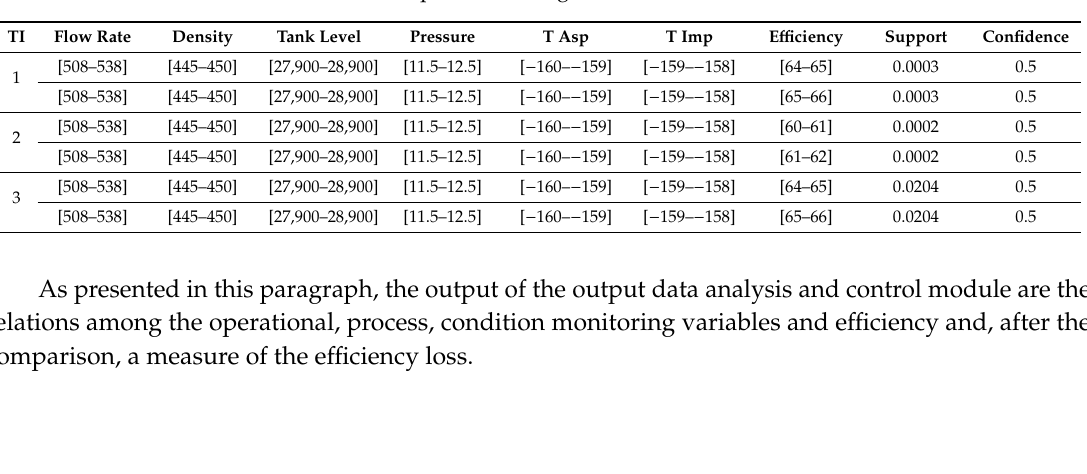
Table 11. Rules comparison among the identified time